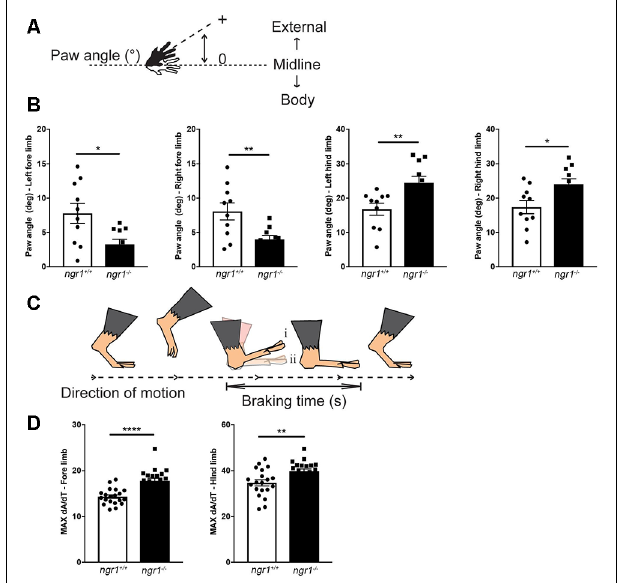
FIGURE 4 | Altered paw angle and rate of deceleration during the braking phase in naïve ngr1 − / − mice. For detailed methods please see the Supplementary Information . (A) Absolute paw angle is the angle that the paw makes with the long axis of the direction of motion (midline). Higher absolute paw angles represent greater degrees of external rotation. (B) The forepaws of naïve NgR1-KO ( ngr1 − / − ) mice are less externally rotated than naïve wildtype mice ( ngr1 +/+ ), while NgR1-KO hind paws are more externally rotated than WT mice. (C) The maximal rate of change of the paw area (MAX dA/dT) provides a measure of how rapidly the animal decelerates during the braking phase. An increased MAX dA/dT represents a greater change in paw area over the same amount of time; therefore, compared to its littermate (i), the animal is placing its paw down faster (ii; modified from Vincelette et al., 2007). (D) KO mice had an increased MAX dA/dT compared to WT mice for both fore- and hind-paws. Data are presented as mean ± SEM. Unpaired t -test. * P < 0.05, ** P < 0.01, **** P <